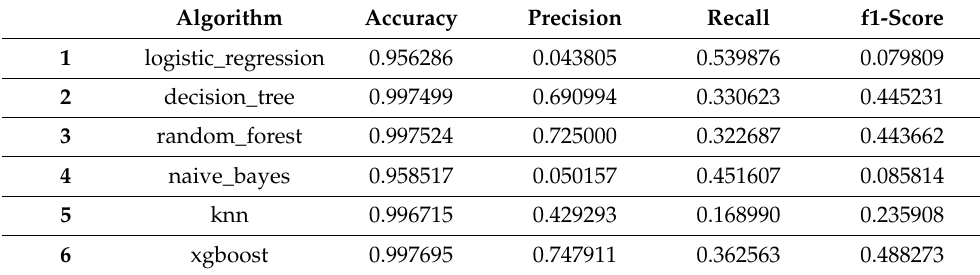
Table 3. Model Performance Comparison. Algorithm Accuracy Precision